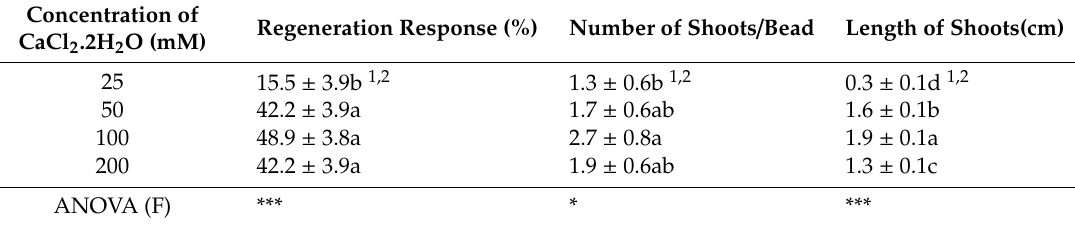
Table 4. Influence of di ff erent concentrations of calcium chloride (CaCl 2 .2H 2 O), in combination with 2.5% sodium alginate, on subsequent artificial seed germination of V. dentatum